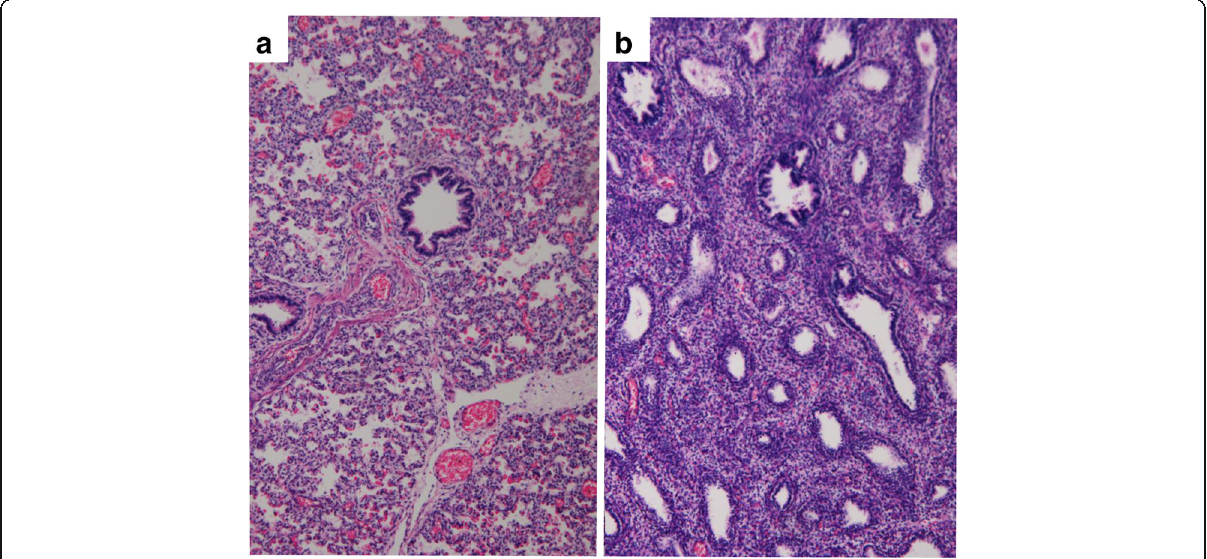
Fig. 6 Microscopic images. a The lungs of the fetus are developed into the saccular stage (hematoxylin and eosin [HE] stain, × 100). b The lung seen in the epignathus is in the canalicular stage and is immature compared to the lungs of the fetus (HE stain, × 100)